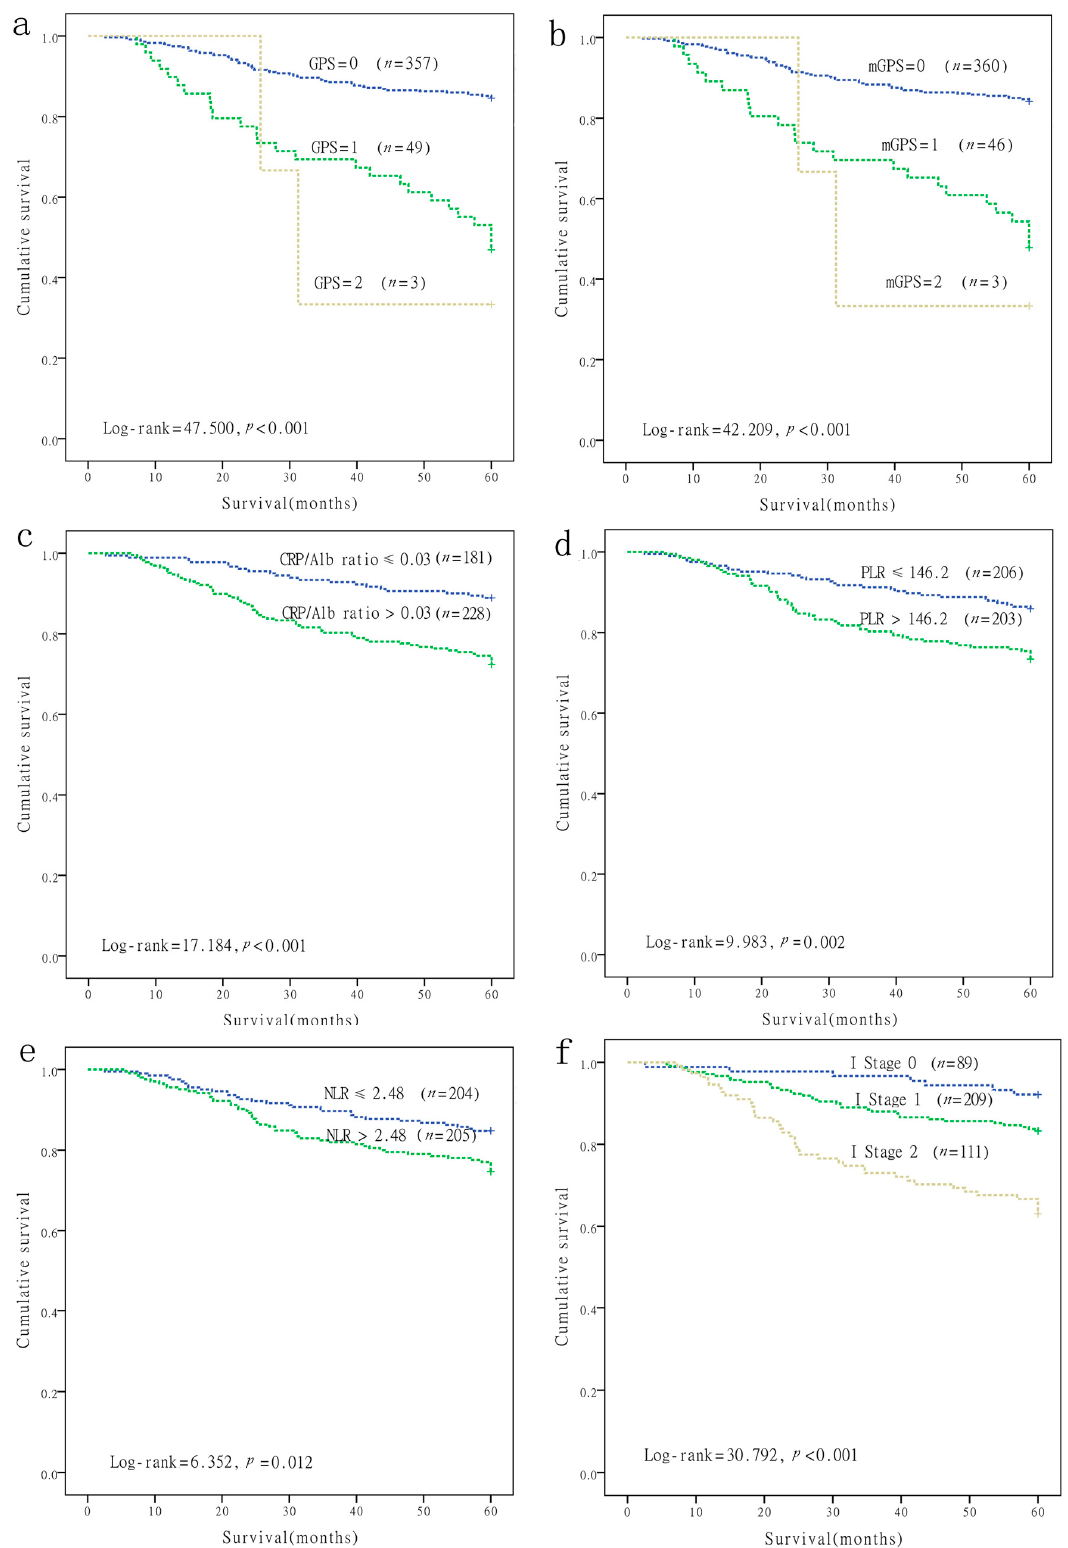
Figure 1. Kaplan-Meier survival curves of nasopharyngeal carcinoma (NPC) patients. ( a ) Overall survival of patients with GPS ( p < 0.001); ( b ) Overall survival of patients with mGPS ( p < 0.001); ( c ) Overall survival of patients with CRP/Alb ratio ( p < 0.001); ( d ) Overall survival of patients with PLR ( p = 0.002); ( e ) Overall survival of patients with NLR ( p = 0.012); ( f ) Overall survival of patients with I stage ( p < 0.001).